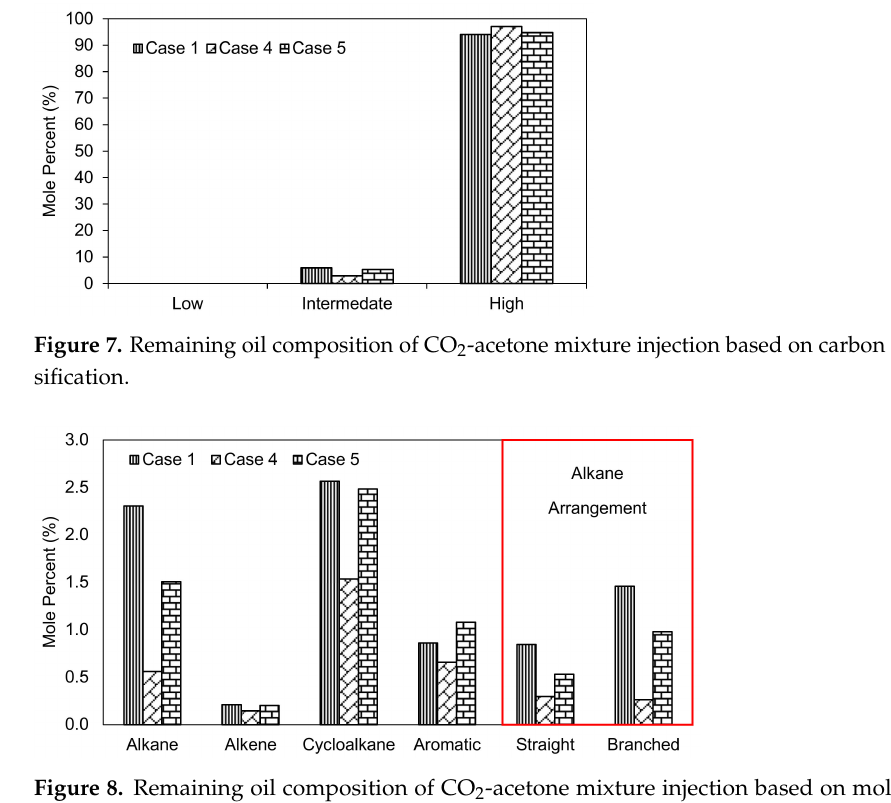
Figure 8. Remaining oil composition of CO 2 -acetone mixture injection based on molecular struc- ture